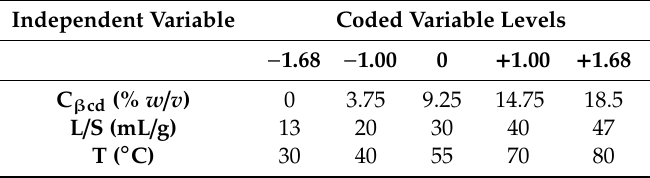
Table 1. Experimental values and coded levels of the independent variables used for the central composite design. C β cd , β -cyclodextrin concentration; L / S, liquid-to-solid ratio; T, temperature.